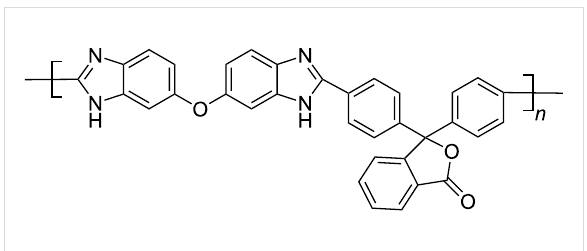
Figure 1: Chemical structure of poly[oxy-3,3-bis(4 ′ -benzimidazol-2 ″ - ylphenyl)phtalide-5 ″ (6 ″ )-diyl] (PBI-O-PhT).